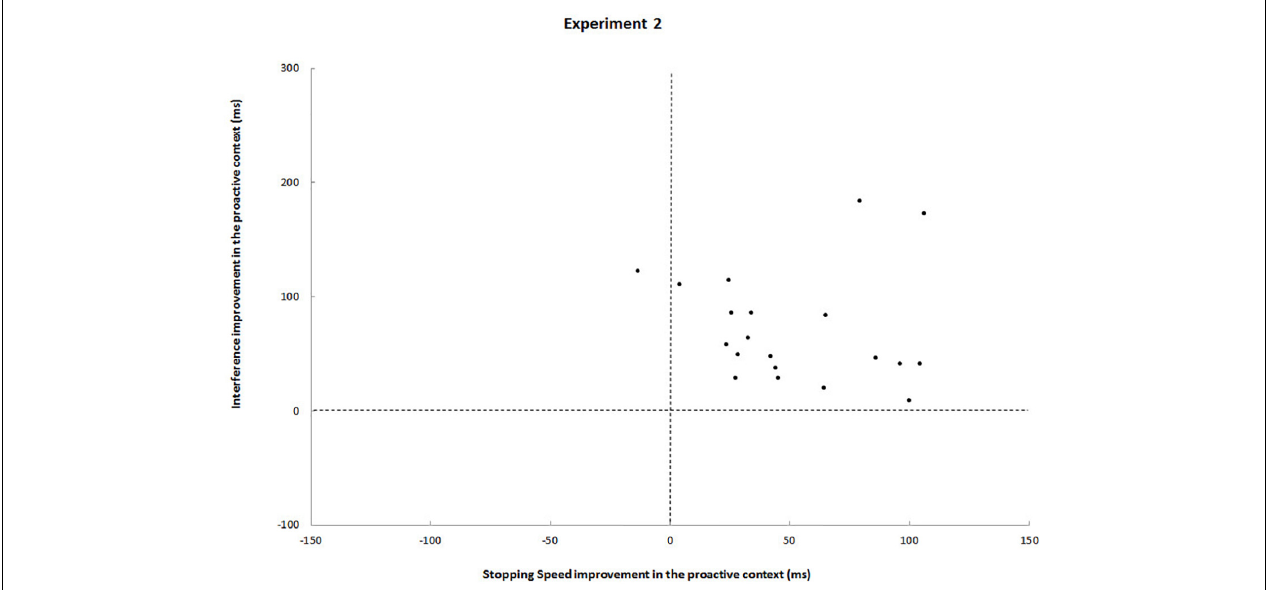
FIGURE 3 | Each black dot represents a participant. Upper left quadrants, participants who improved from foreknowledge in interference but deteriorated in stopping speed; Upper right quadrants, participants who improved from foreknowledge in both interference and stopping speed; Lower left quadrants, participant who deteriorated in both measures; Lower right quadrants, participants who improved from foreknowledge in stopping speed stopping speed but deteriorated in